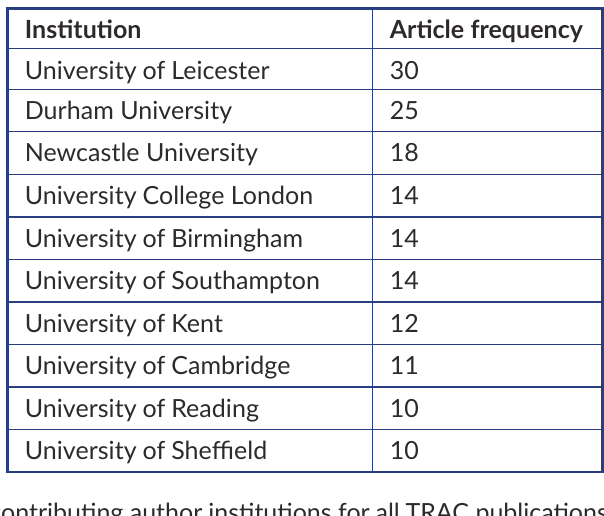
Table 3: Ten largest contributing author institutions for all TRAC publications.